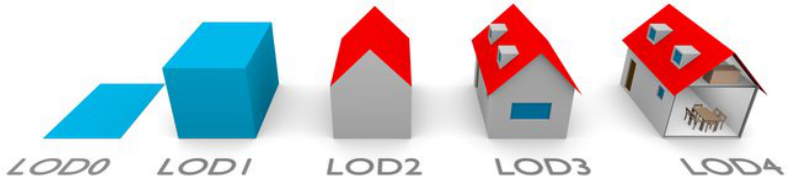
Figure 1. The five levels of the LoD standard, from the leftmost 2.5D polygon LoD-0, to the right- most complex 3D LoD-4, which also contains the interior structures. This figure is reprinted with permission from Ref. [14]. Copyright 2016,